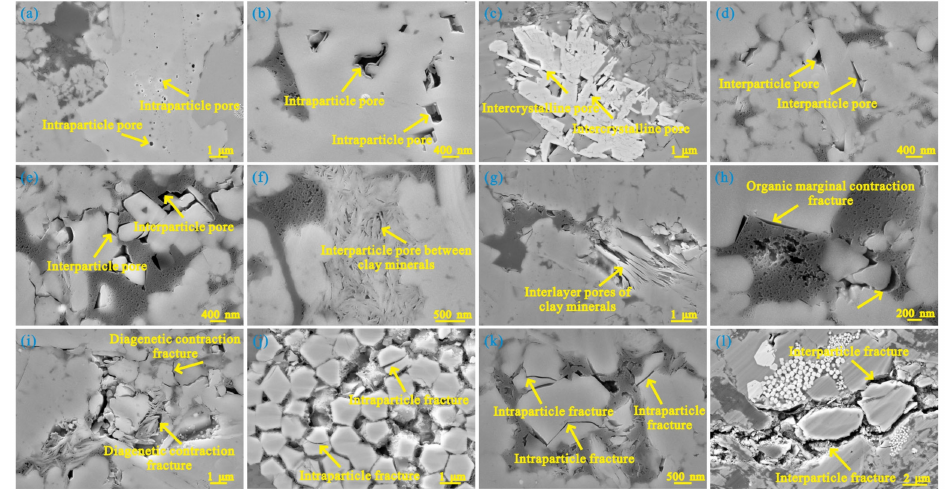
Figure 9. Characteristics of non-organic pores and microfractures in the Dalong Formation shale sam- ples from well ED-2. ( a ) Intraparticle pores developed within calcite (1244.2 m depth). ( b ) Intraparticle pores filled with a bitumen layer of homogeneous thickness (1249.2 m depth). ( c ) Interparticle pores developed between recrystallized dolomite grains (1234.2 m depth). ( d ) Interparticle pores developed between quartz and feldspar grains (1229.6 m depth). ( e ) Interparticle pores developed between quartz and organic matter (1229.6 m depth). ( f ) Slit pores between clay minerals (1244.2 m depth). ( g ) Elongated and parallel-plate pores between clay minerals (1252.9 m depth). ( h ) Contraction fractures developed at the edge of organic matter (1229.6 m depth). ( i ) Diagenetic fractures developed between rigid minerals and clay mineral grains (1234.2 m depth). ( j ) Intraparticle fractures developed within a pyrite framboid (1244.2 m depth). ( k ) Intraparticle fractures developed within quartz grains (1237.2 m depth). ( l ) Interparticle fractures developed between mineral grains (1249.2 m